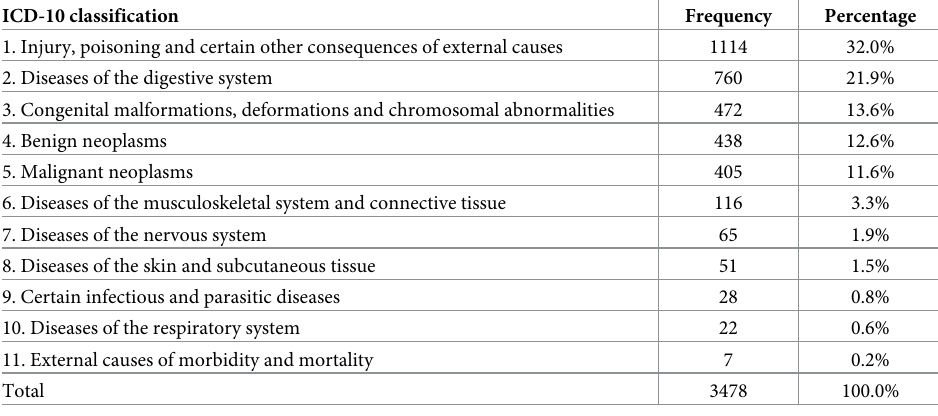
Table 3. Diagnosis distribution by ICD-10 classification.